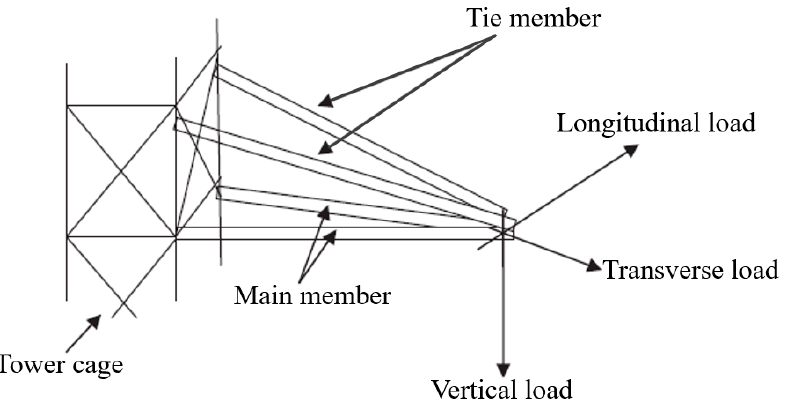
Figure 1. Position of cross-arm components at the cage of the tower (reproduced with copyright permission from Selvaraj et al. [31]). permission from Selvaraj et al.